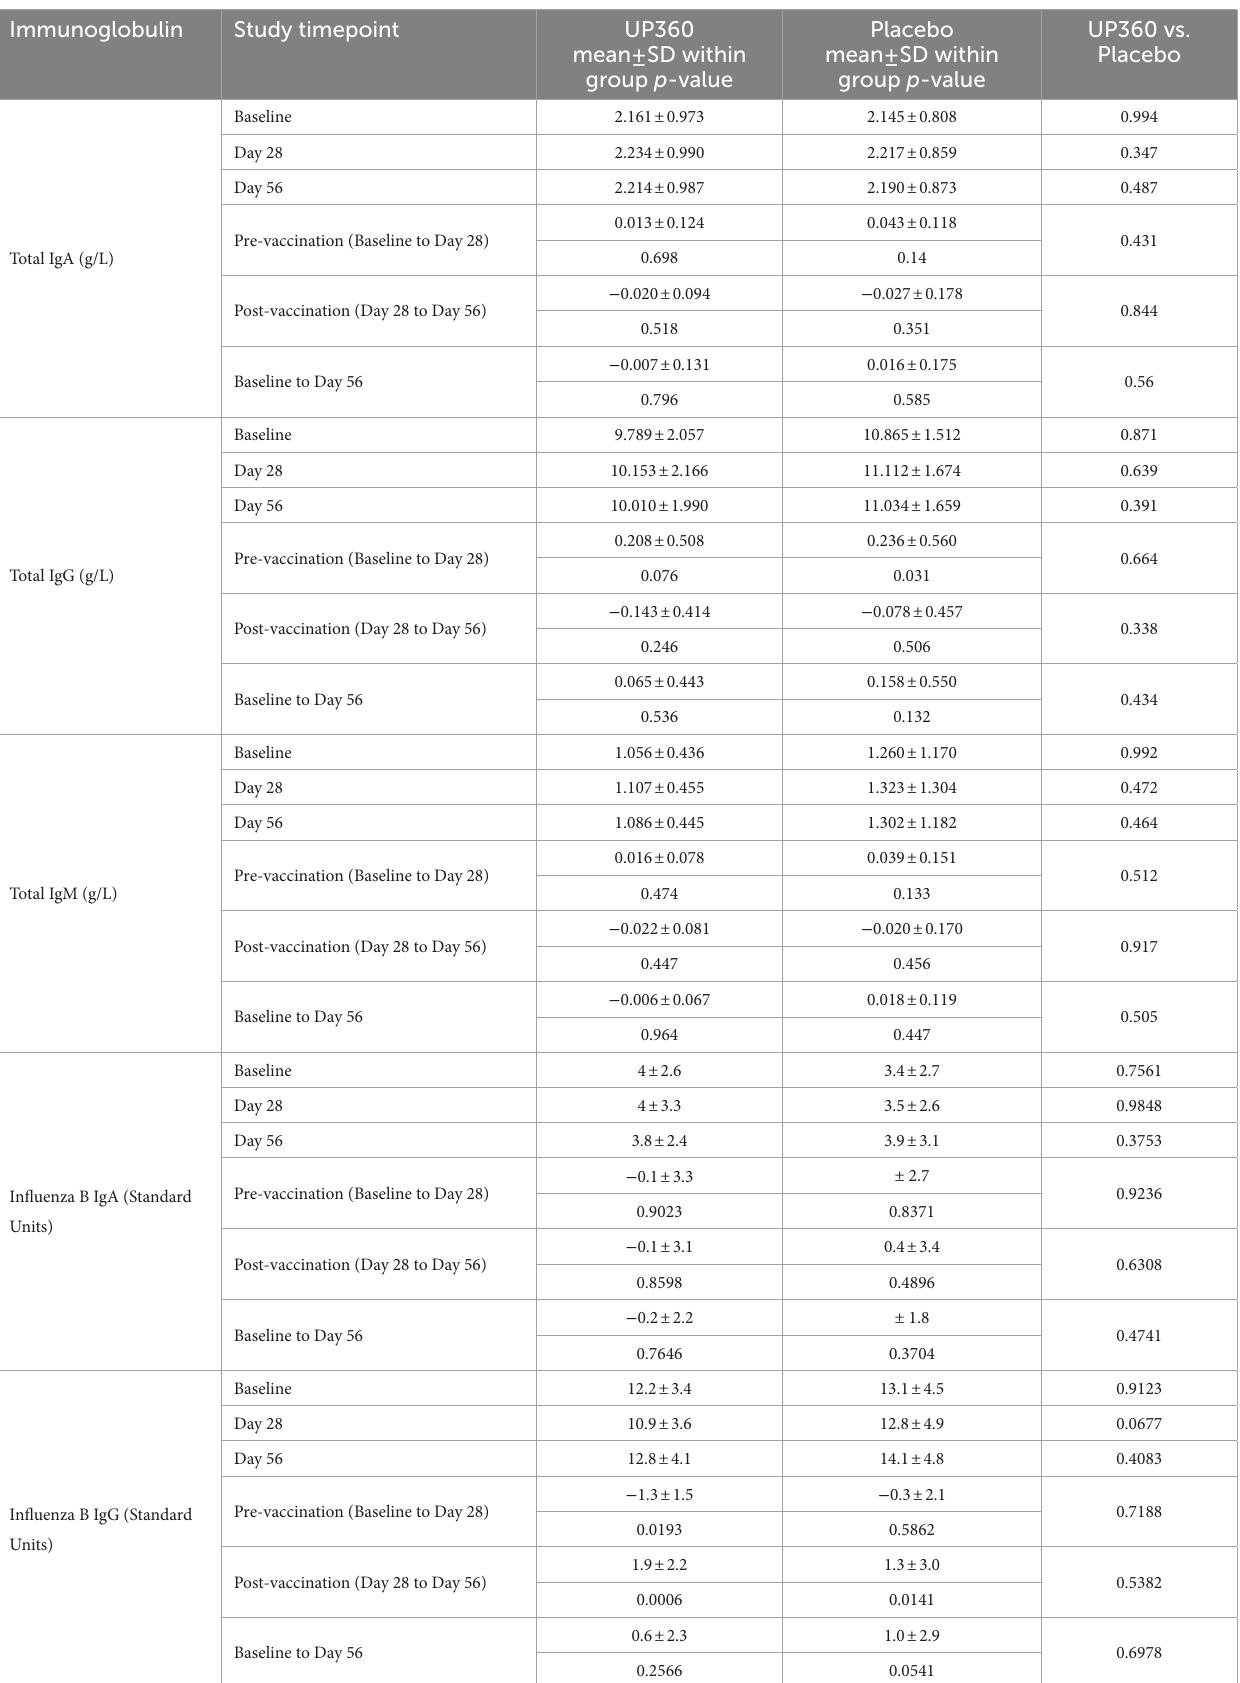
TABLE 2 Total immunoglobulin and influenza-B specific immunoglobulin concentrations in blood of participants ( n = 50). Immunoglobulin Study timepoint UP360